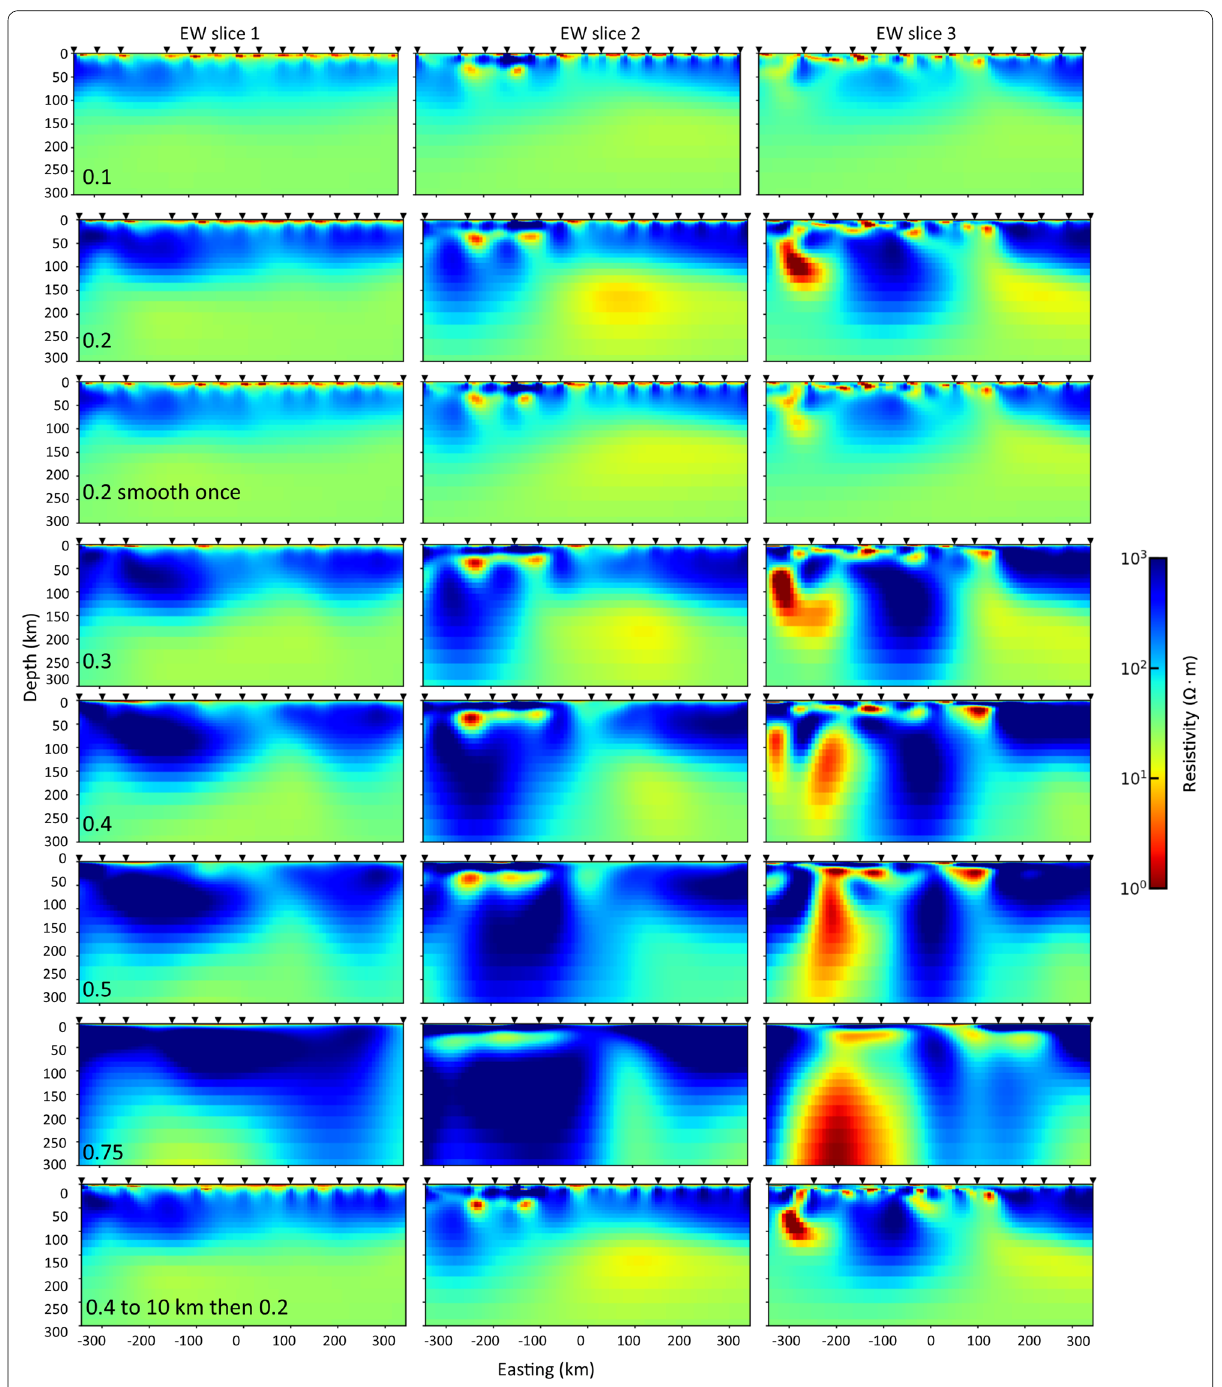
Fig. 13 East–west cross section through model to a depth of 300 km with covariance of 0.1, 0.2, 0.2 with the smoothing applied once, 0.3, 0.4, 0.5, 0.75 and 0.4 to 10 km then 0.2 beneath. The locations of these transects are shown in Fig.